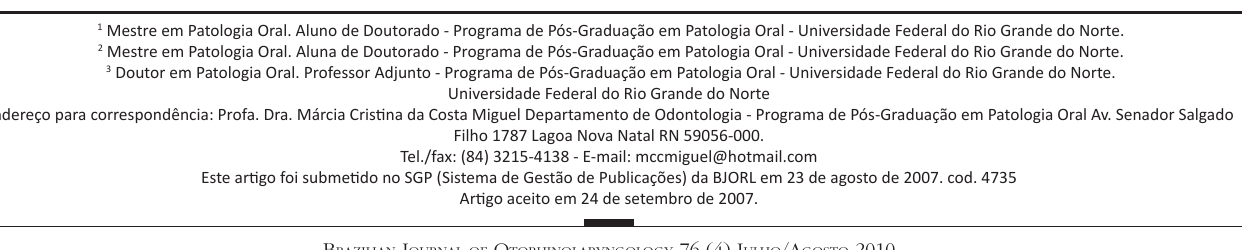
Figura 1. (a) Lesão separada do epitélio de revestimento da mucosa oral por faixa de tecido conjuntivo fibroso, exibindo ainda extensas áreas de calcificação (HE/ 40x); (b) detalhe das calcificações dispersas entre os feixes de células fusiformes (HE/ 200x); (c) intensa marcação para actina de músculo liso no cito- plasma das células neoplásicas, entremeadas por calcificações irregulares (Estreptoavidina-biotina/ 400x); (d) presença de célula gigante multinucleada em associação a áreas de calcificação (Estreptoavidina-biotina/